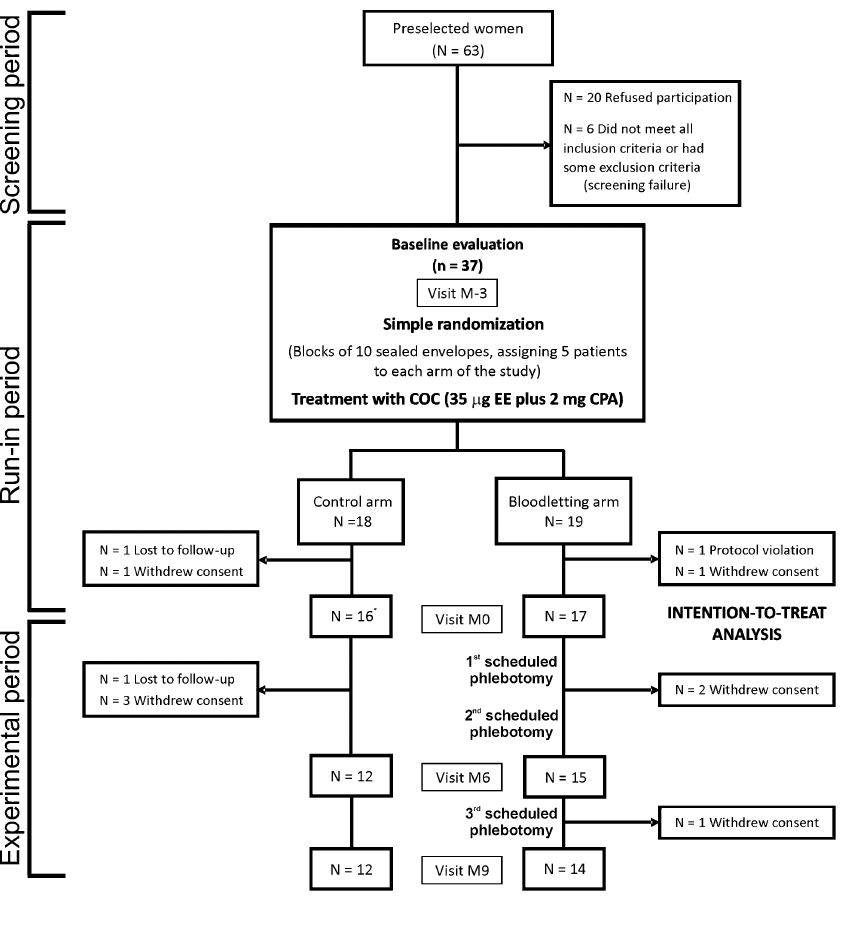
Figure 1. Flow chart of the